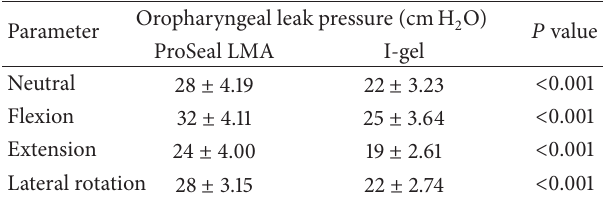
Table 6: Oropharyngeal leak pressures between devices.